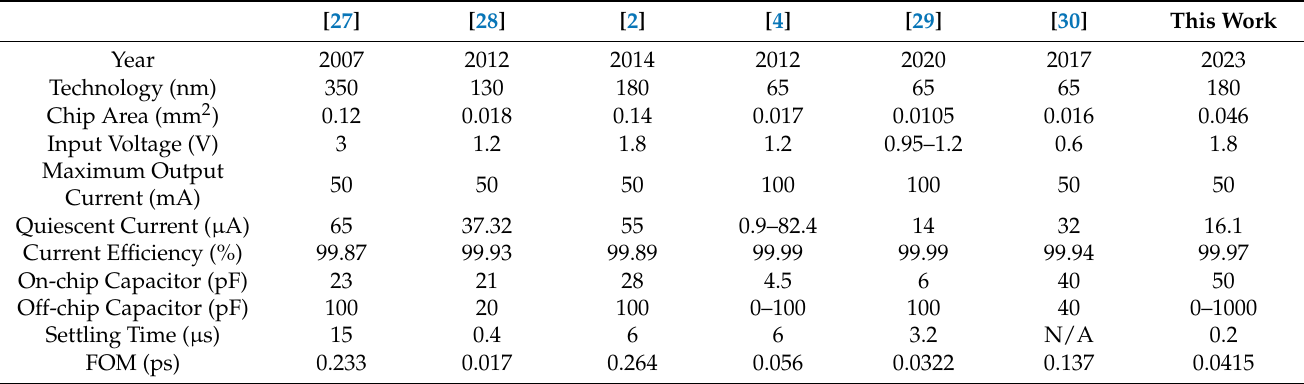
Table 1. Performance summary and comparison of